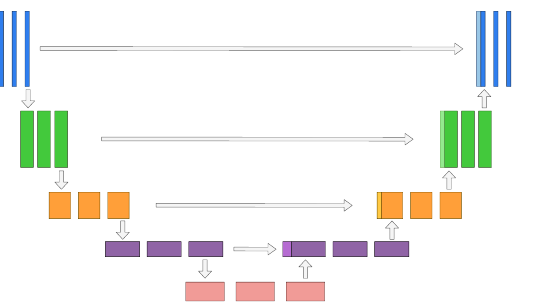
Figure A2. Architecture of the mutli-scale, post-processing U-Net. The general architecture of a U-Net consists on a downsampling path on the left and a upsampling path on the right with intermediate connection between similar scales. Adapted from